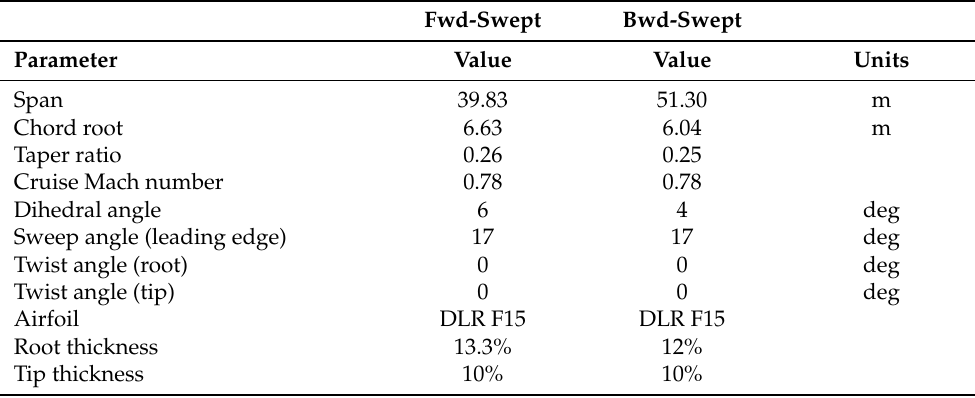
Table 2. SE 2 A Midrange aircraft reference